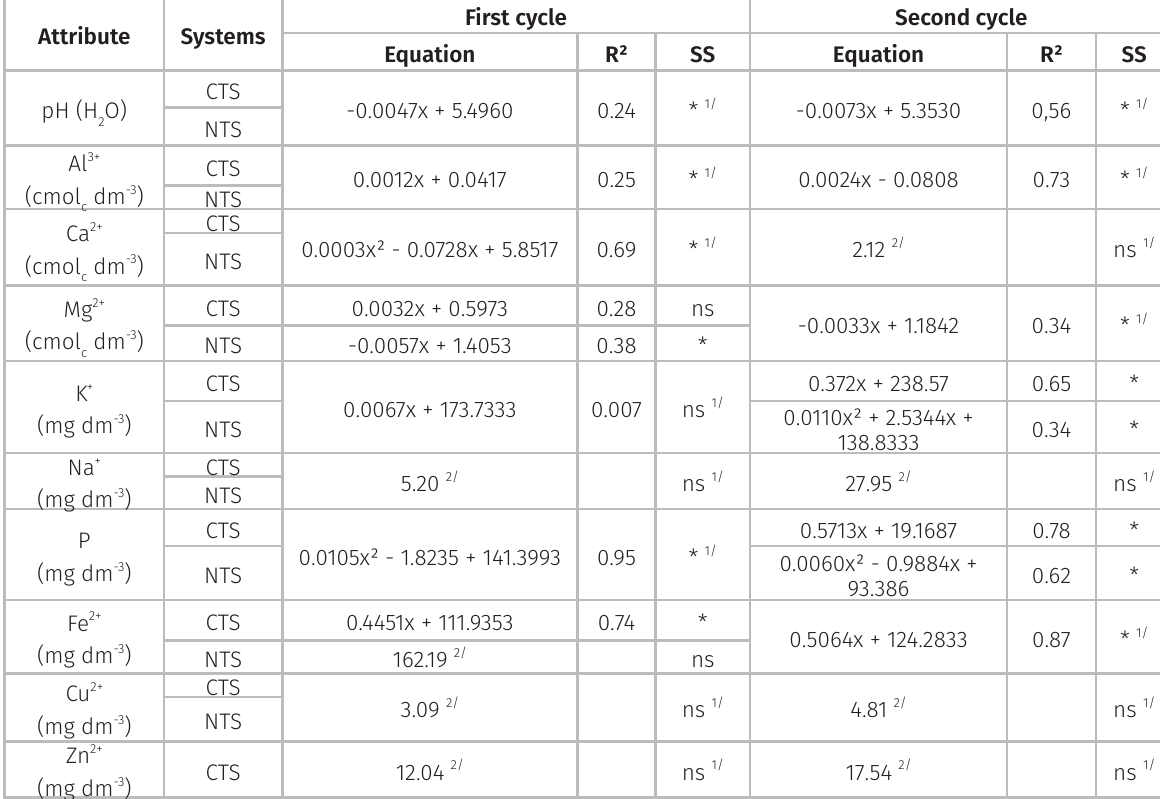
Table V. Regression equations adjusted between chemical soil attributes as dependent variables of depth of irrigation with SW, at a depth of 0–0.1 m, in different soil management systems (CTS and